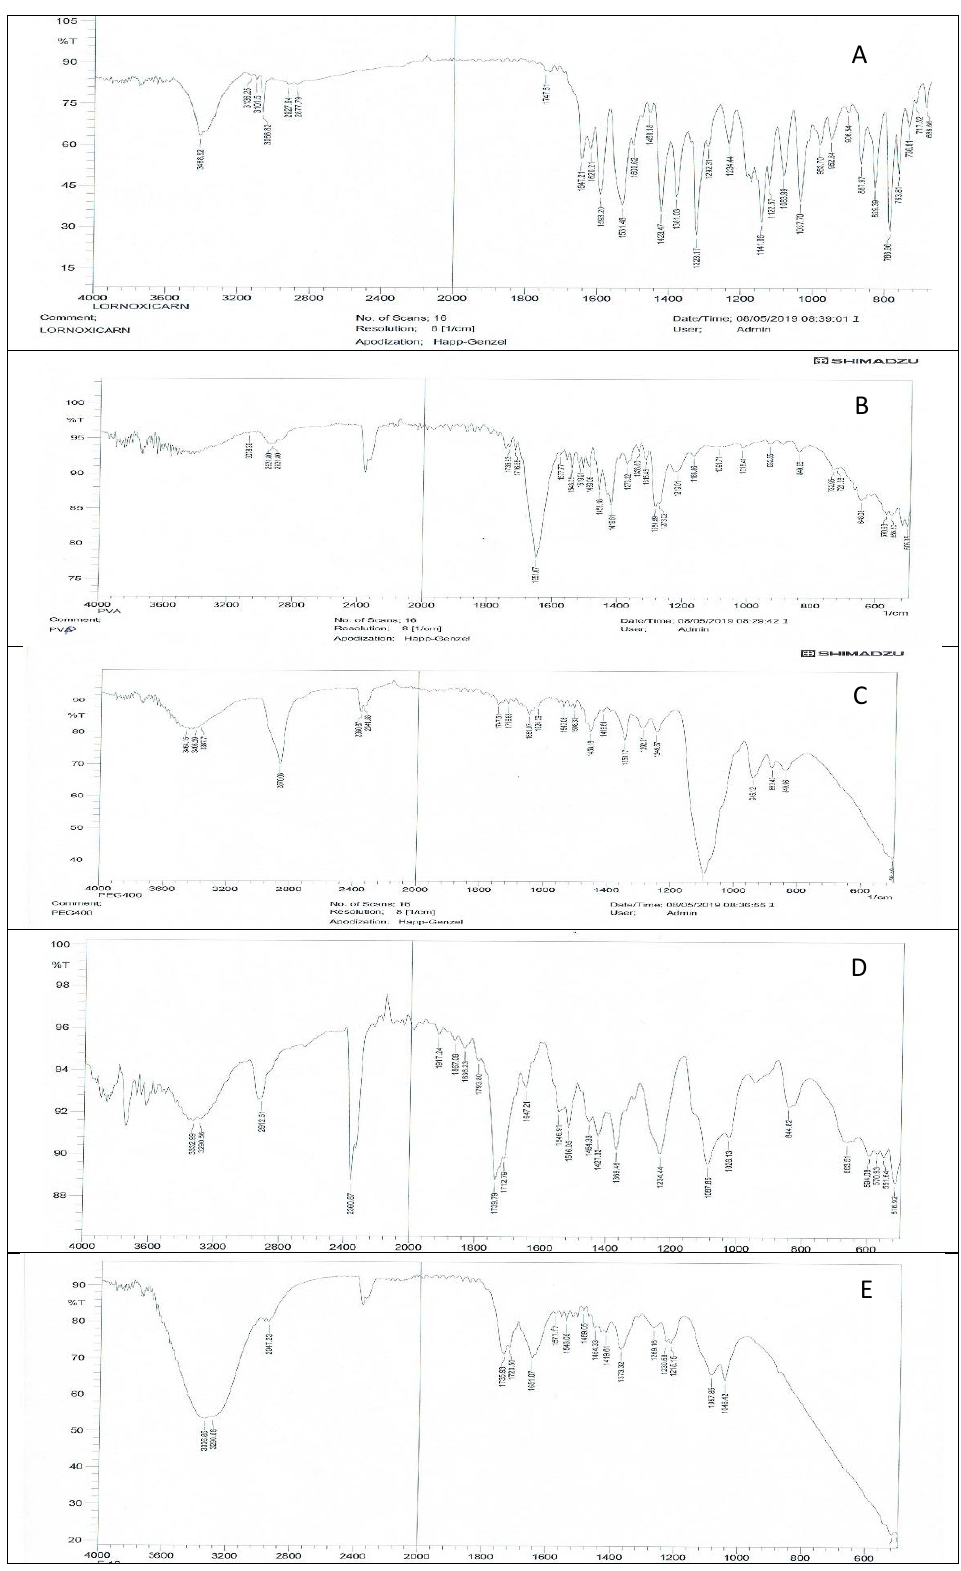
Figure 7. Compatibility FTIR, IR spectrum of A: Lornoxicam, B: PVP, C: PEG 400, D: PVA and E selected